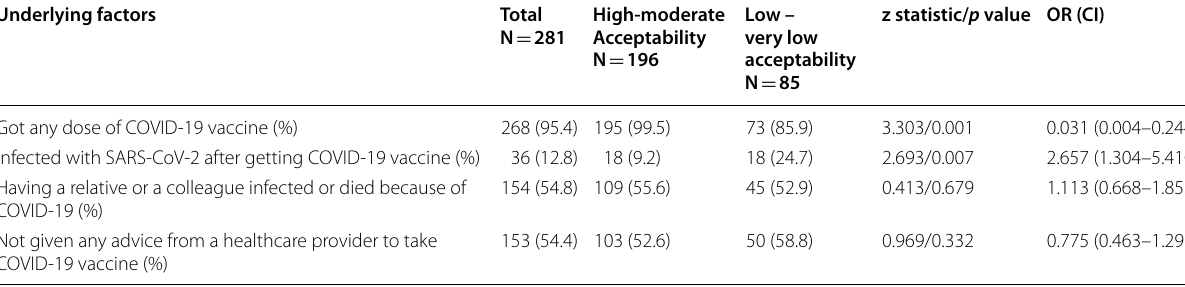
Table 2 The acceptance rate among studied participants relative to underlying factors Underlying